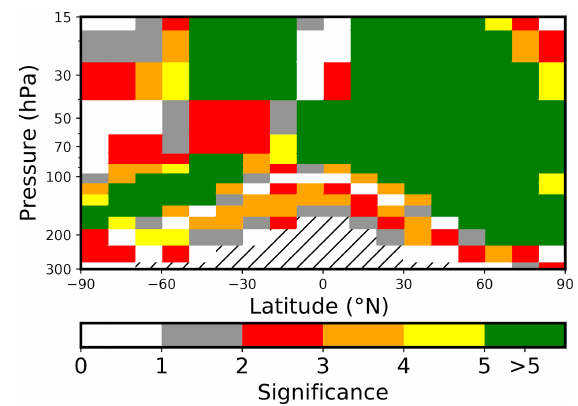
Figure 11. Statistical significance (inverse relative error) of the de- termined trends. Dashed areas represent pressure levels and latitude bins with too few